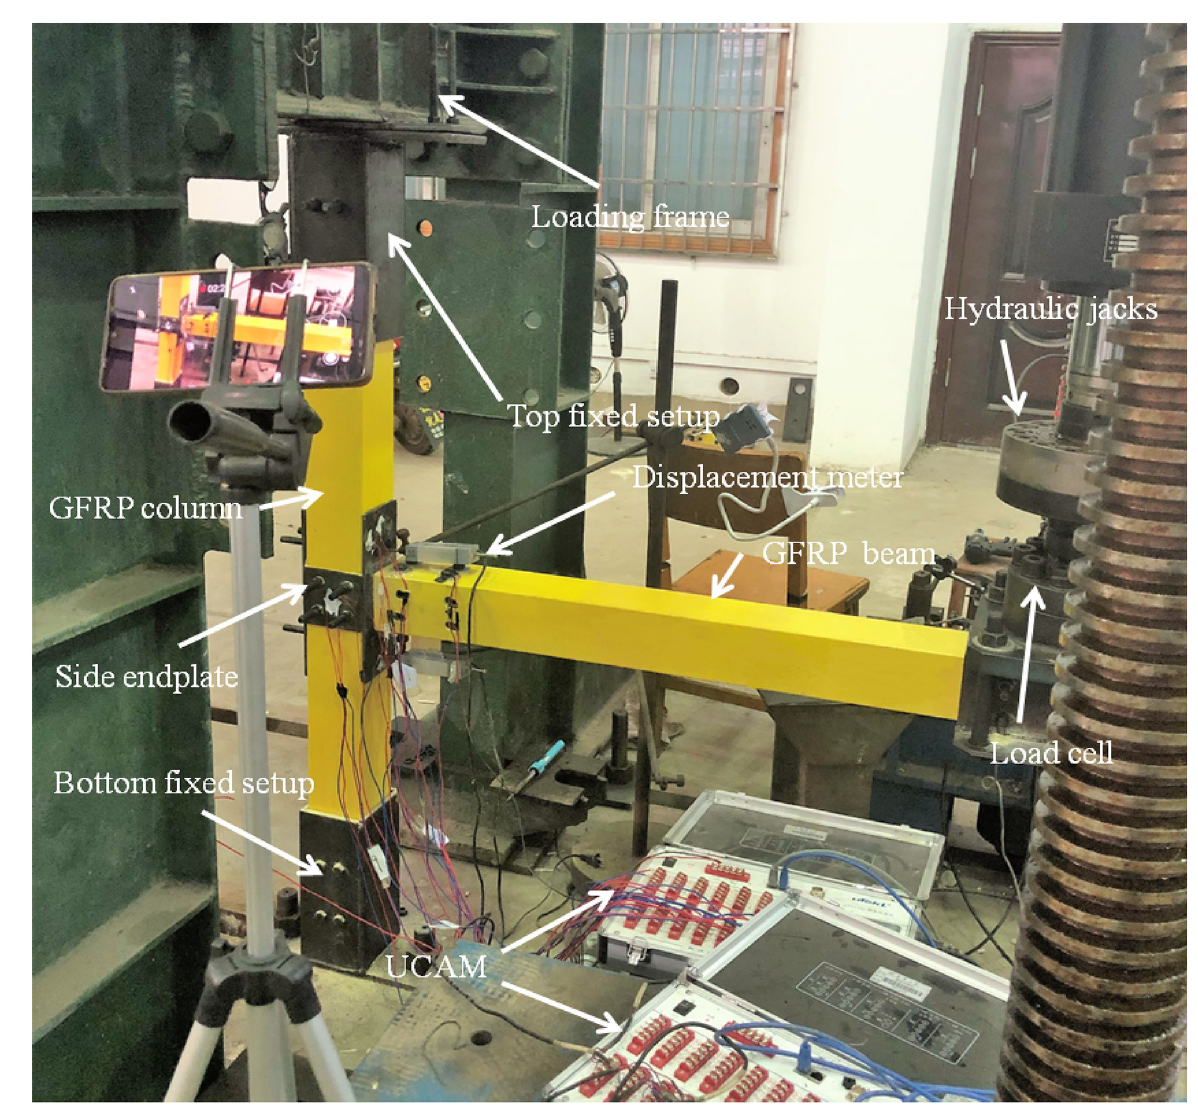
Fig 3. Experimental set-up for